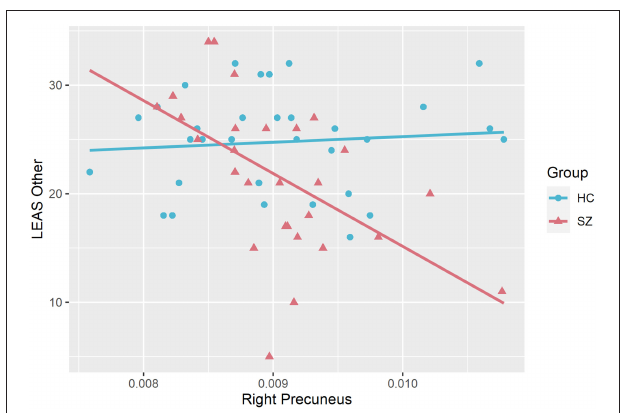
FIGURE 1 | Correlations between emotional awareness for others (LEAS Other) and gray matter volume of right precuneus significant in schizophrenia group (SZ) but not in healthy controls